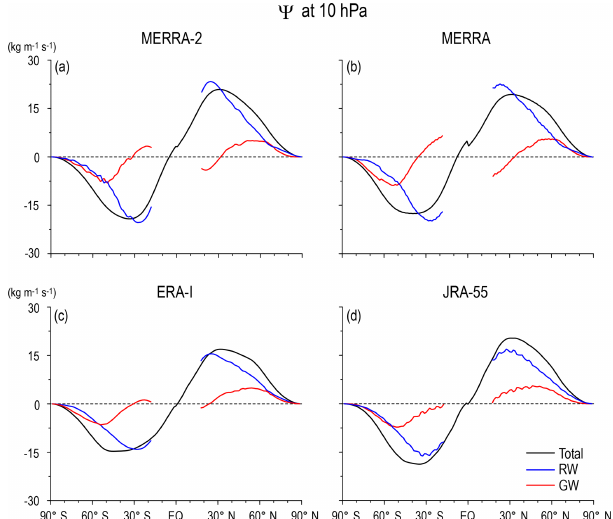
Figure 4. The same as Fig. 3 but for 10hPa.